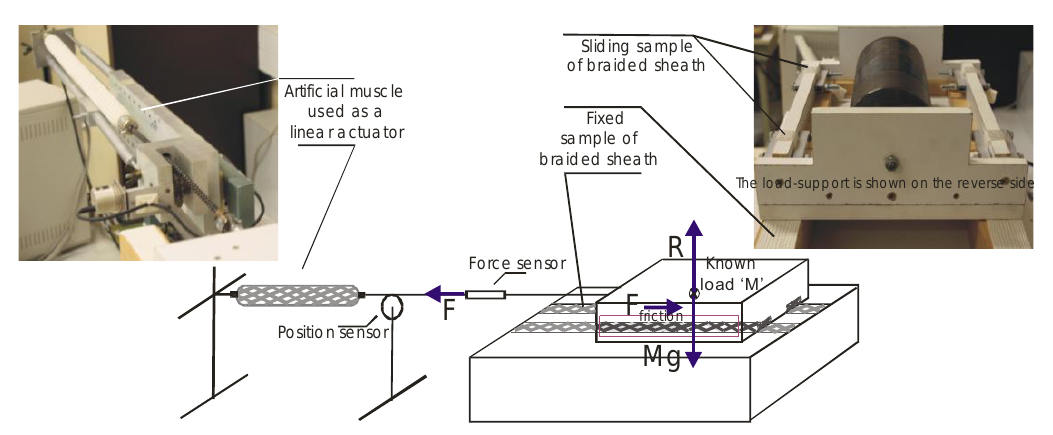
Figure 3. Experimental apparatus used to estimate the kinetic friction of a flattened sample of our rayon braided sleeve sliding over itself.